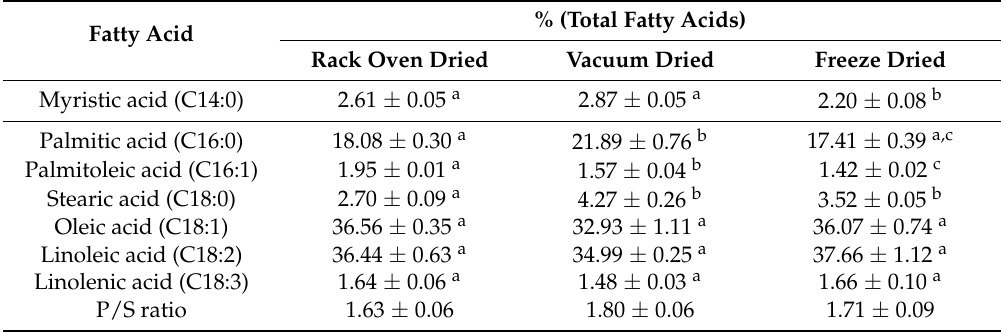
Table 3. Fatty acid composition of rack oven dried, vacuum dried and freeze dried mealworm